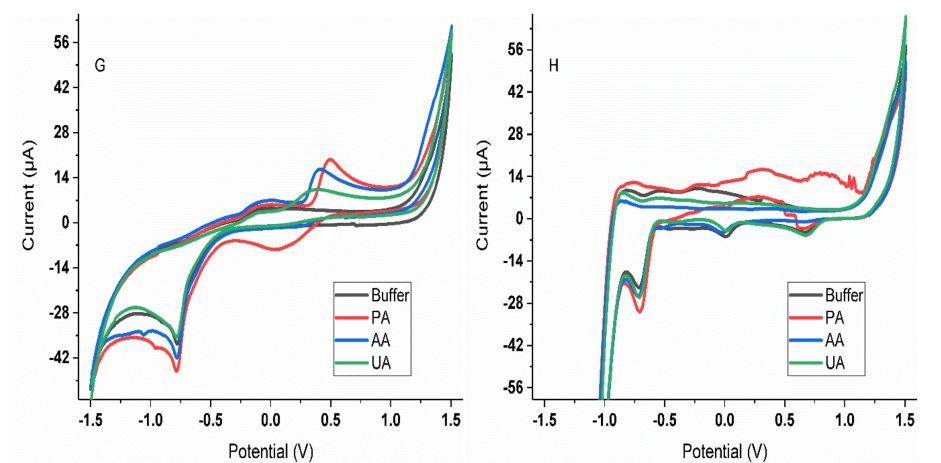
Figure 2. Voltammograms obtained for the three APIs (250 µ M in phosphate bu ff er) using the GECs modified with ( A ) SnO 2 , ( B ) Prussian Blue, ( C ) ZnO, ( D ) PPy, ( E ) CoPc, ( F ) TiO 2 and ( G ) Bi 2 O 3 , and ( H ) the metallic Pt